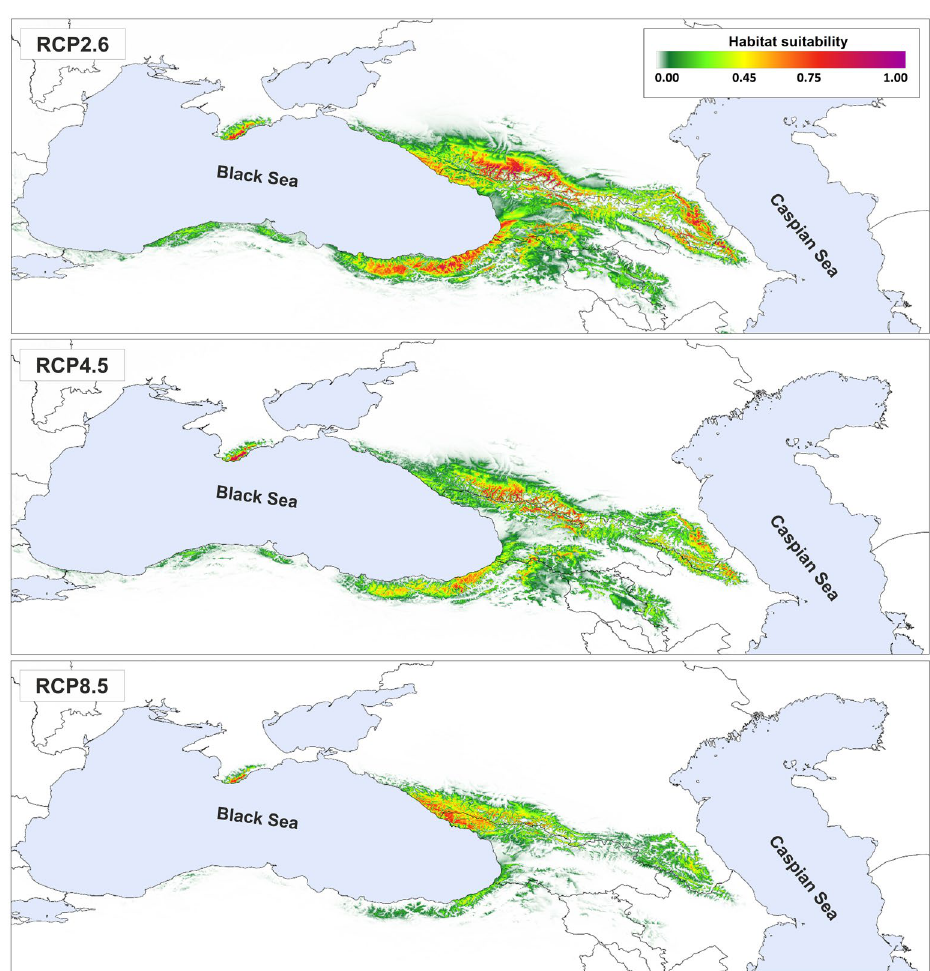
Figure 6. Predicted future range of Scots pine in the Caucasus and Anatolia according to different scenarios. RCP2.6—future range according to scenario RCP2.6; RCP4.5—future range according to scenario RCP4.5; RCP8.5—future range according to scenario RCP8.5. Figure generated with QGIS 3.16 (https:// qgis. org/ en/